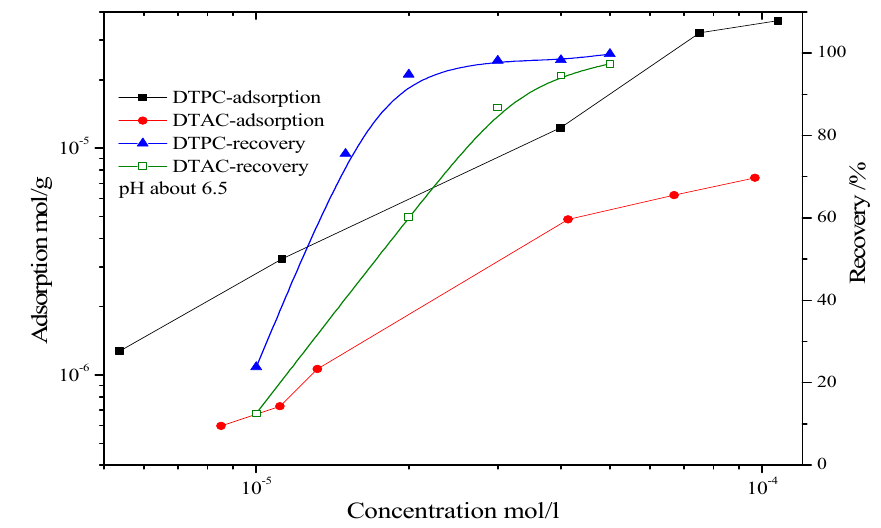
Figure 10. The correlation of the valuable mineral flotation recovery and the adsorption amount of TTPC or DTAC with respect to collector concentration.